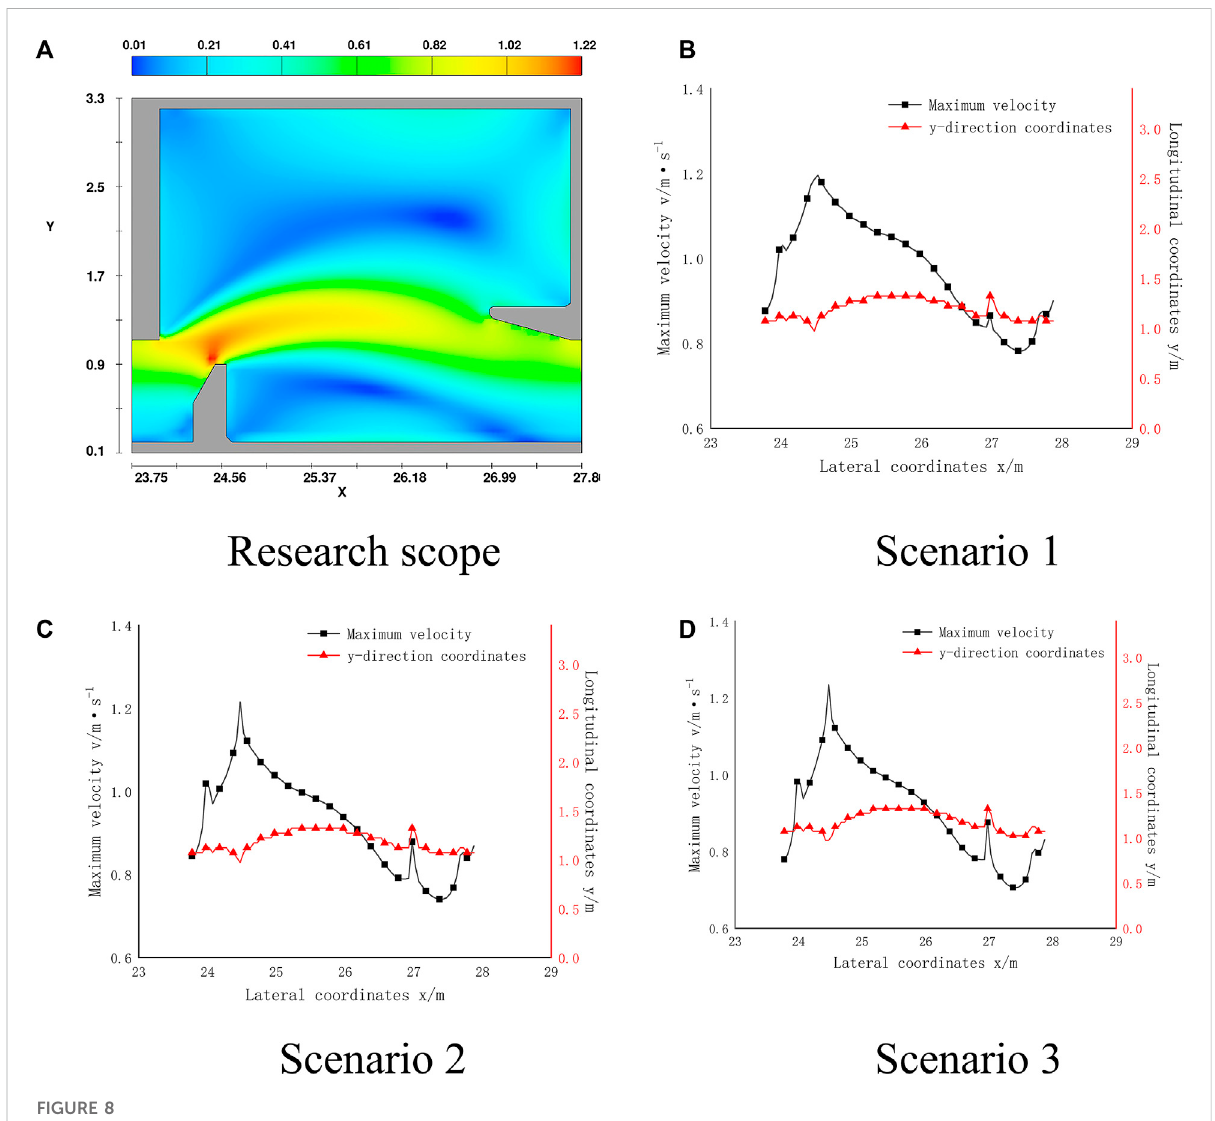
FIGURE 8 Maximum velocity and position along the way.